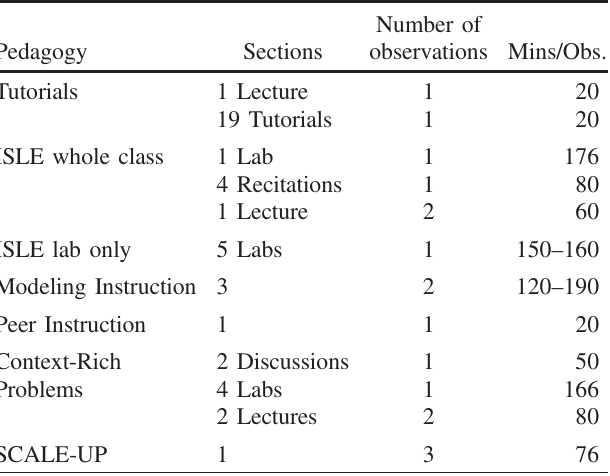
TABLE V. Number of course sections and observations for each pedagogy included in this study. We also include the approximate length, in minutes, of each